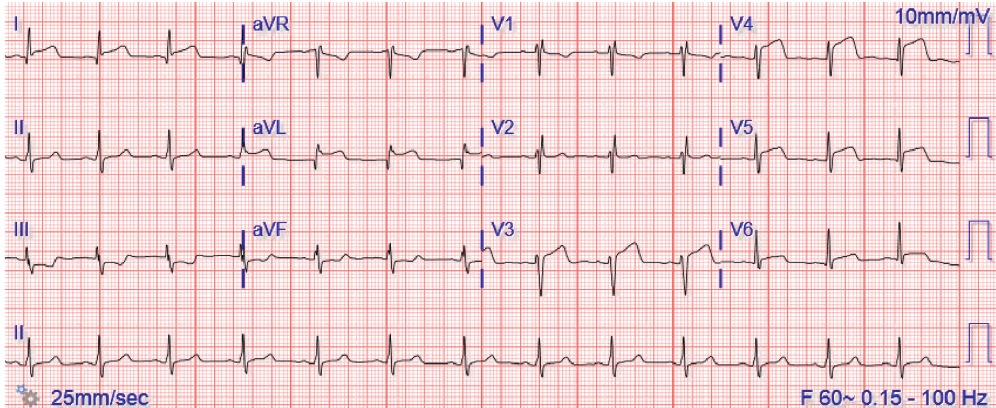
Figure 3: The patient’s EKG on the morning of day 2. There were STelevations in lead I, aVL, and the precordial leads overlying the anterior and lateral surfaces of the heart (V3–V6), which was consistent with anterolateral infarction. These findings were not present on admission (Figure 1).